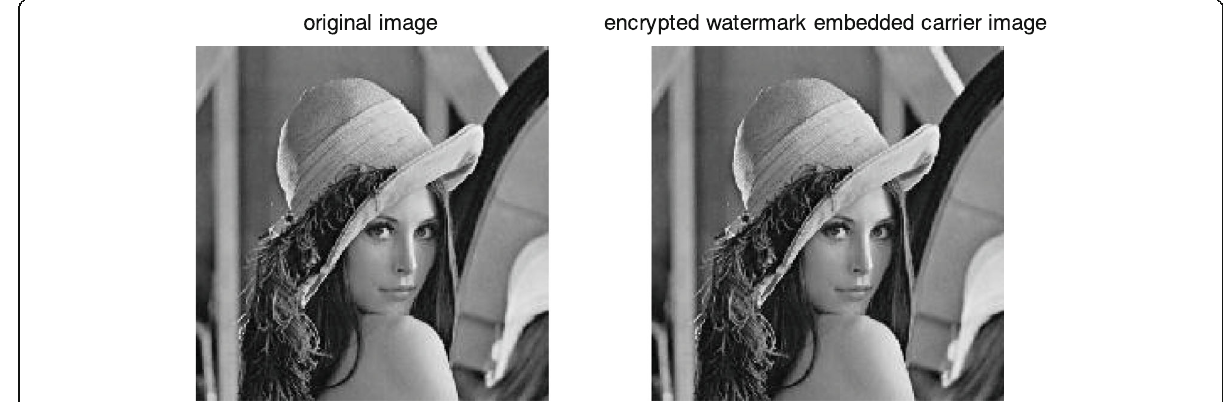
Fig. 8 original image and watermarked image after